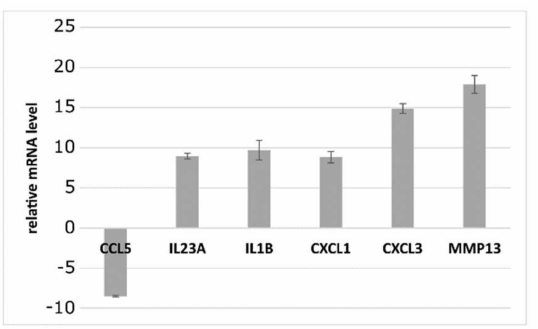
Figure 1. The relative expression levels of selected mRNAs in the platelet-rich plasma specimens. Data represent the expression levels of CCL5, IL23A, IL-1 β , CXCL1, CXCL3 and MMP13 in relation to GAPDH level, measured with the use of qRT-PCR. Data are represented as the mean ± standard deviation of twenty independent experiments.